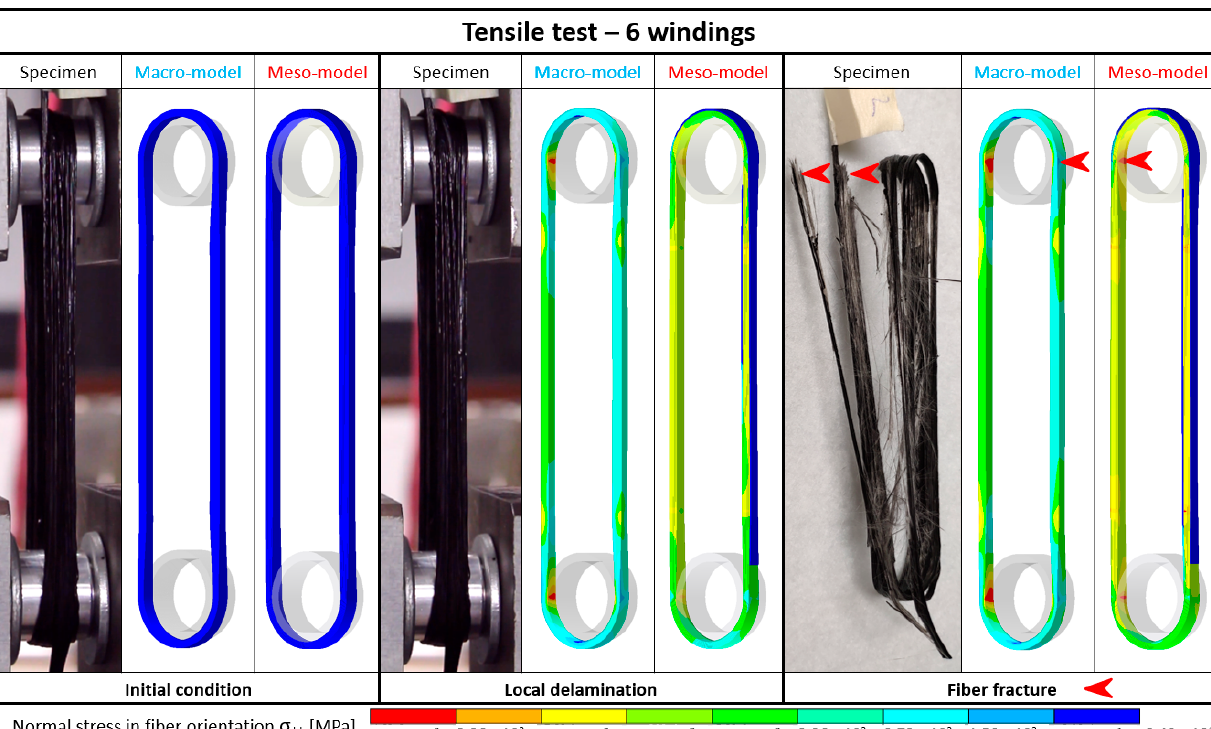
Figure 18. Deformation and failure behavior of simple loops with six windings (specimens and models).